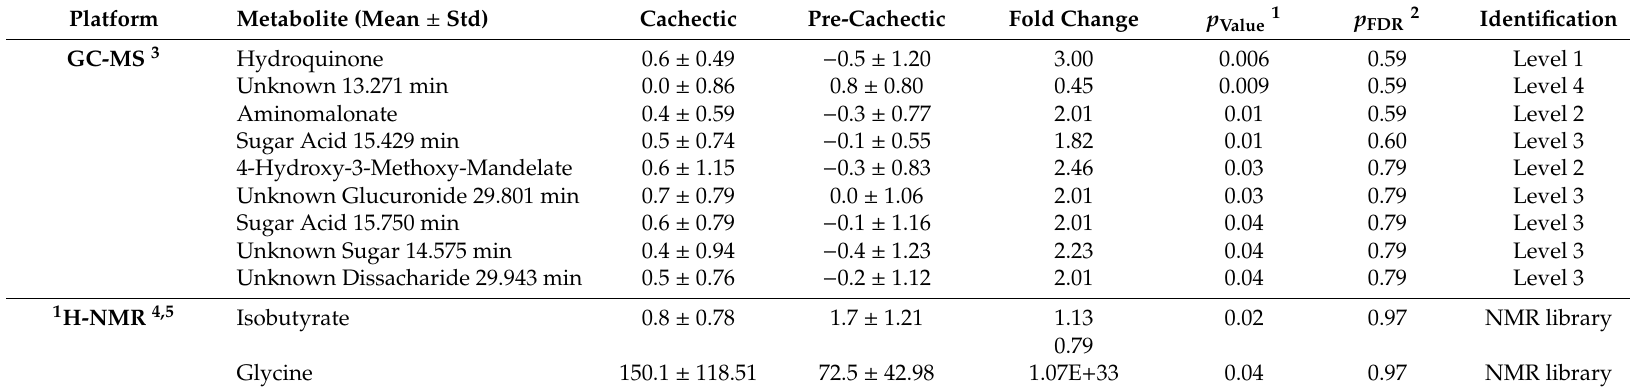
Table 5. Comparison of mean level of metabolites in cachectic and pre-cachectic patients. Intensities of the raw peak area of a certain ion (GC–MS) were normalized by sum, log-transformed, and auto-scaled and each spectral bin ( 1 H-NMR) was normalized to creatinine ( µ mol / mmol creatinine) and auto-scaled. + Platform Metabolite (Mean ± Std) Cachectic